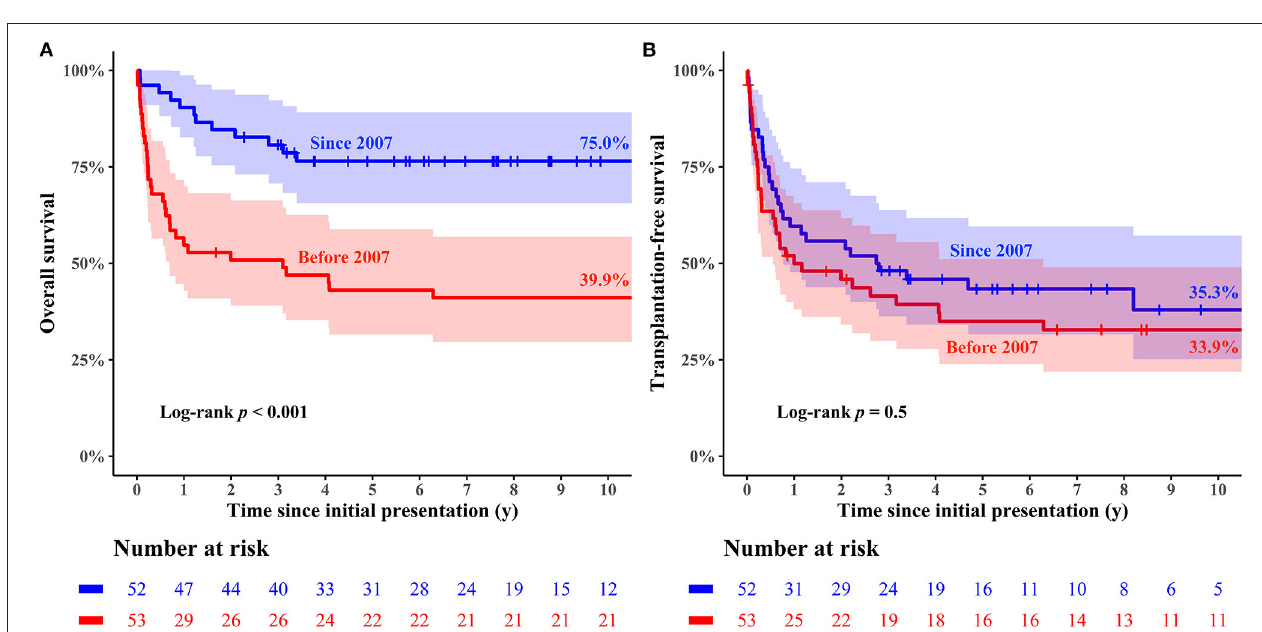
FIGURE 3 | Kaplan–Meier curves of clinical outcomes stratified by eras at initial presentation. (A) overall survival, (B) transplantation-free Survival.